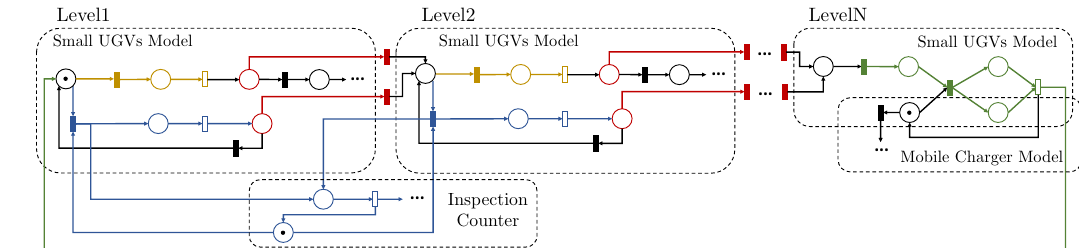
Figure 14. Solar farm full GSPNR model with N battery levels and recharge action. Blue color—inspection model; yellow color—navigation model; red color—discharging model; green color—recharging